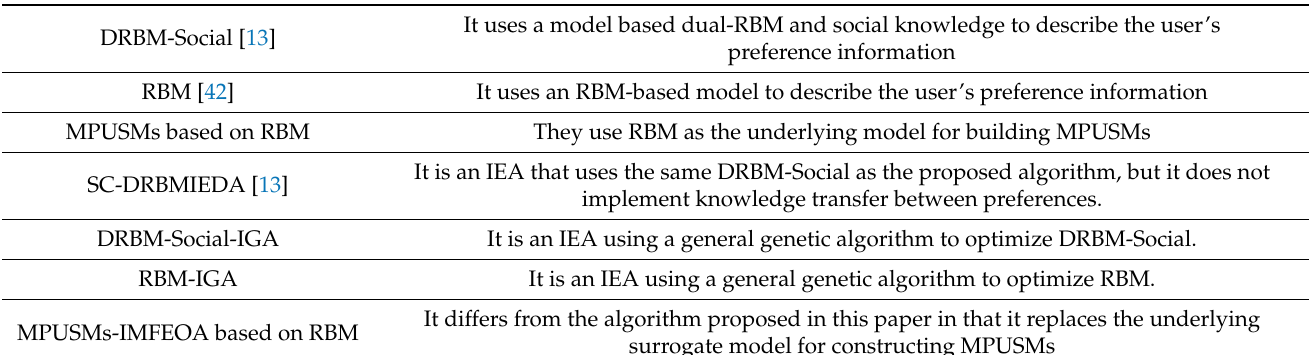
Table 4. The comparison models and algorithms used in this